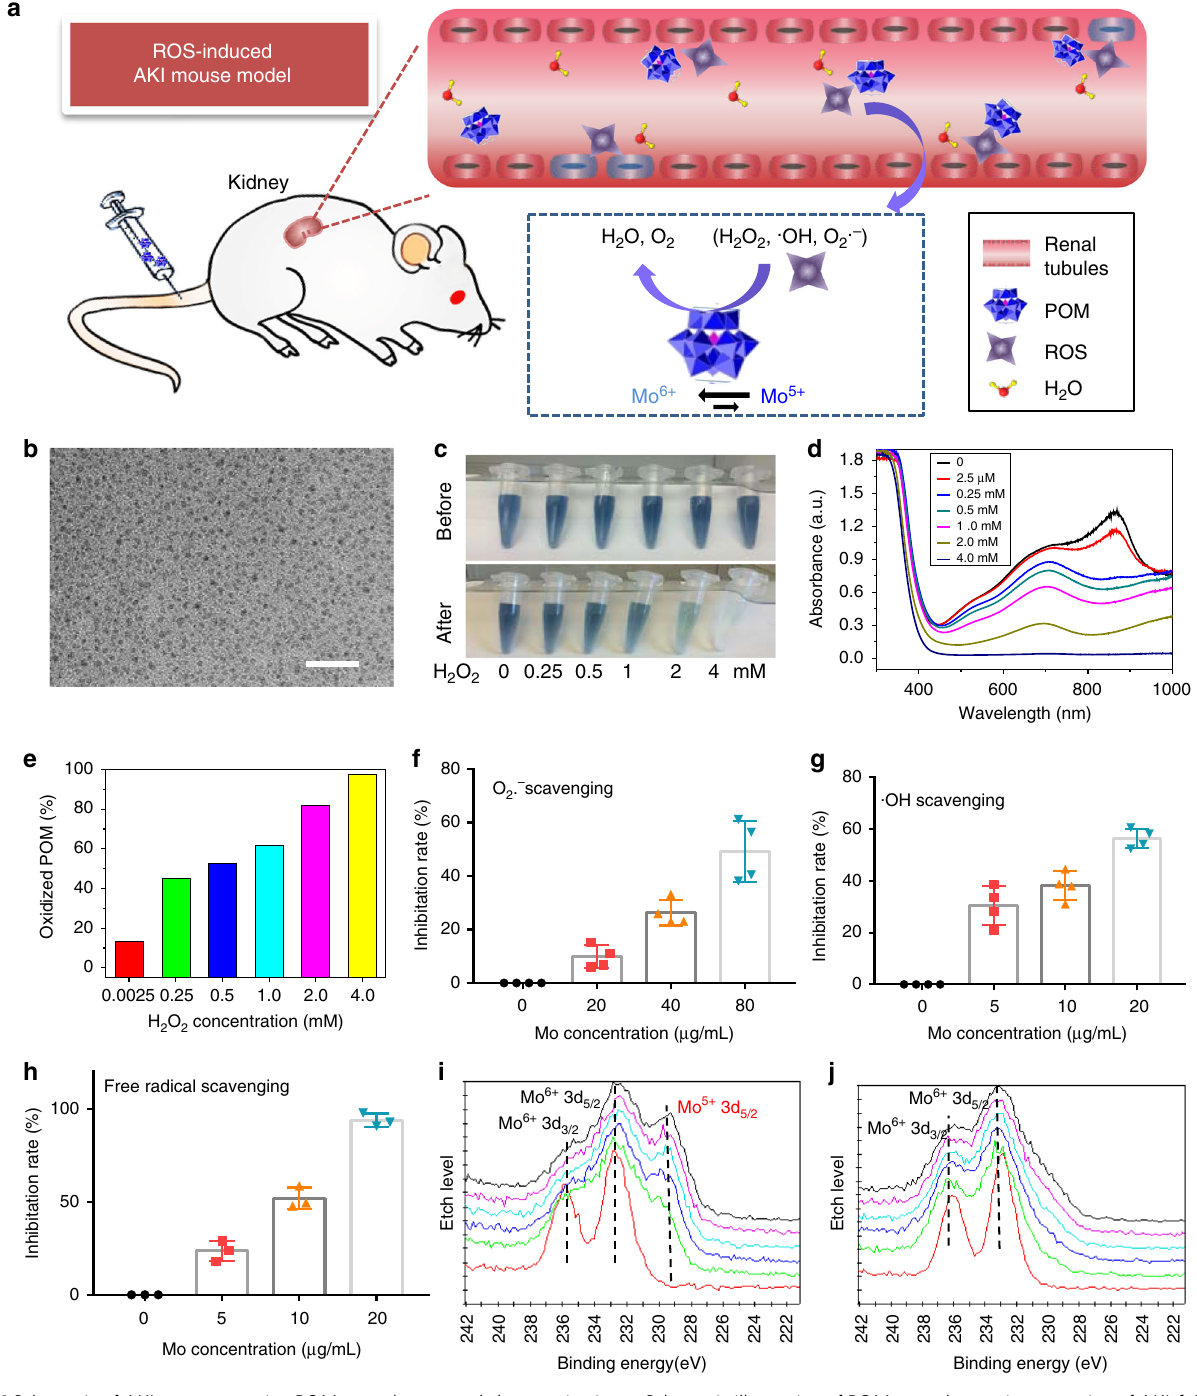
Fig. 1 Schematic of AKI treatment using POM nanoclusters and characterization. a Schematic illustration of POM nanoclusters in prevention of AKI. b TEM image of POM at pH = 7.4; Scale bar: 20 nm. Photographs ( c ) and UV – vis – NIR spectra ( d ) of POM before and after incubation with H 2 O 2 at different concentrations. e Percent oxidized POM calculated from the absorbance peak in d . O 2 (cid:129) − ( f ), (cid:129) OH ( g ), and free radical ( h )-scavenging activity of POM at different concentrations. X-ray photoelectron spectroscopy of POM nanoclusters before ( i ) and after ( j ) oxidizing by the ROS. In f – h , data represent means ± s.d. from three ( h ) or four ( f , and g ) independent